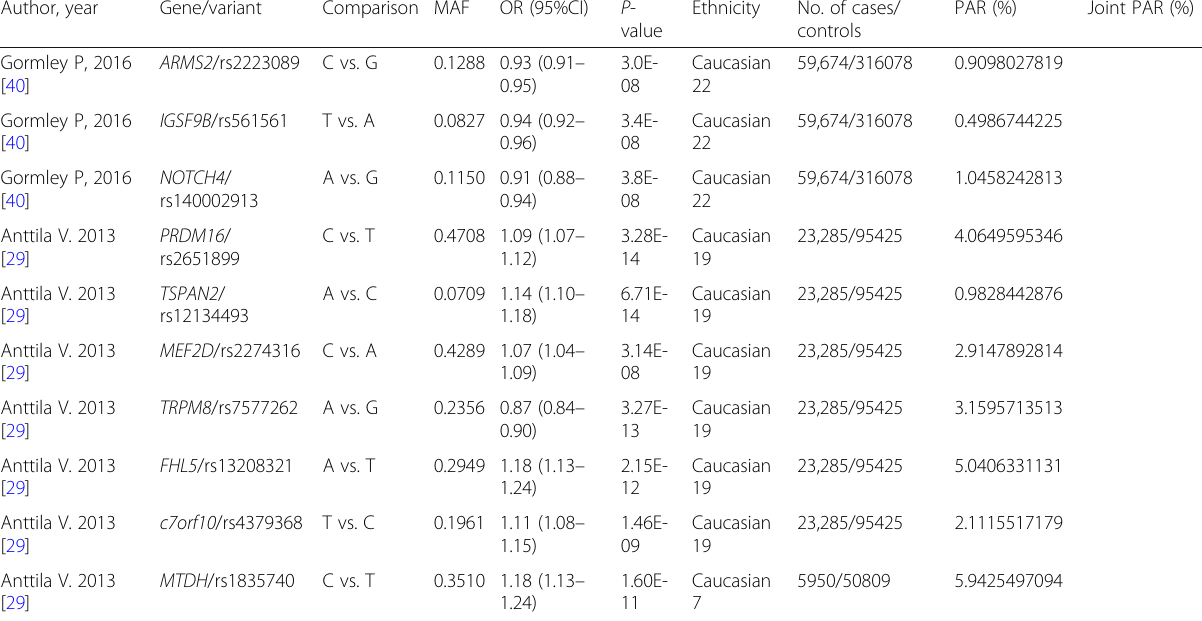
Table 6 Combination of genetic polymorphisms to predict risk of migraine. Calculation of joint PAR% using the SNPs showing noteworthiness during the computing of BFDP (BFDP < 0.8) or FPRP (FPRP< 0.2) at a statistical power to detect the OR of 1.5 (Continued)